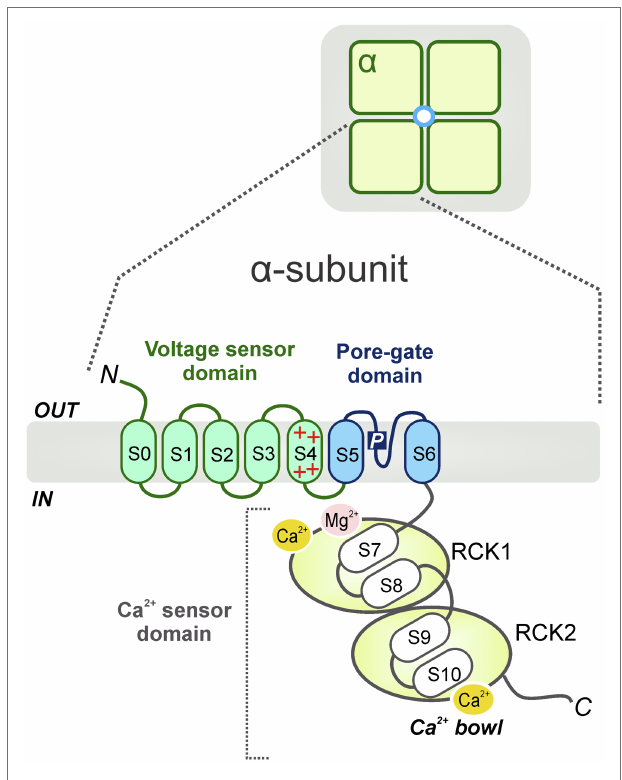
FIGURE 1 | Schematic diagram of the general BK channel structure. BK channels constitute tetramers of the channel pore-forming α -subunits ( top ). Each α ( Slo1 ) subunit contains 3 main domains: a voltage sensor domain (VSD, S0-S4), a pore-gate domain (S5-S6) and a C-terminal cytosolic region, which functions as a Ca 2+ sensor domain (S7-S10) ( bottom ). The Ca 2+ sensor domain is constituted by two non-identical domains (i.e., RCK1 and RCK2) which contain high-affinity binding Ca 2+ sites (Ca 2+ bowl ) and several modulatory domains for multiple ligands or cations including Mg 2+